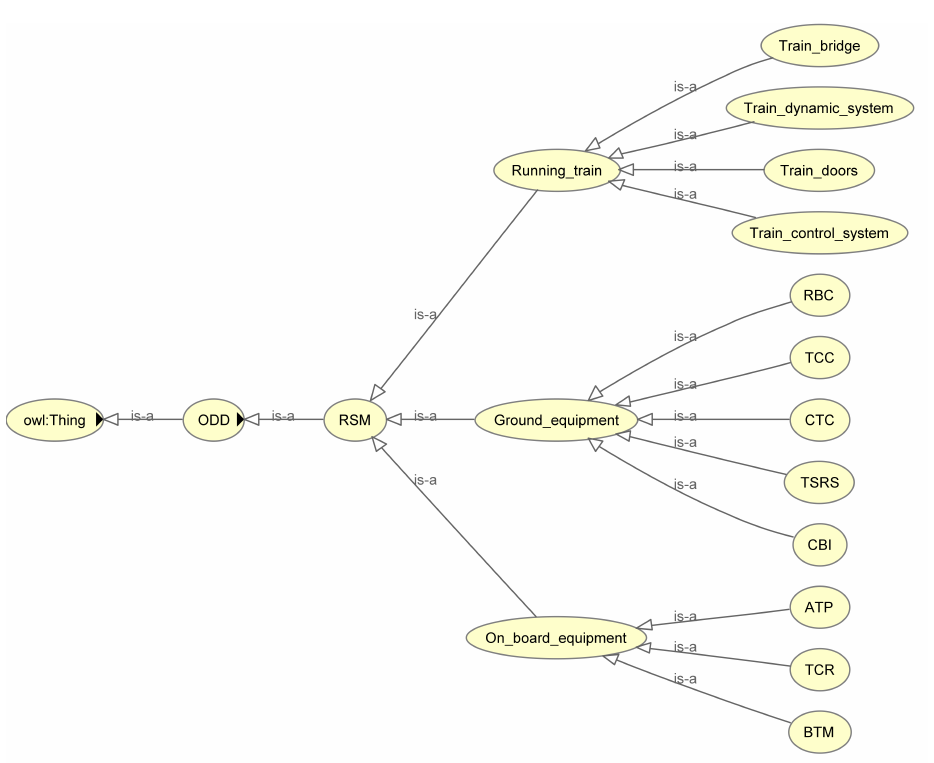
Figure 6. Structure diagram of related system